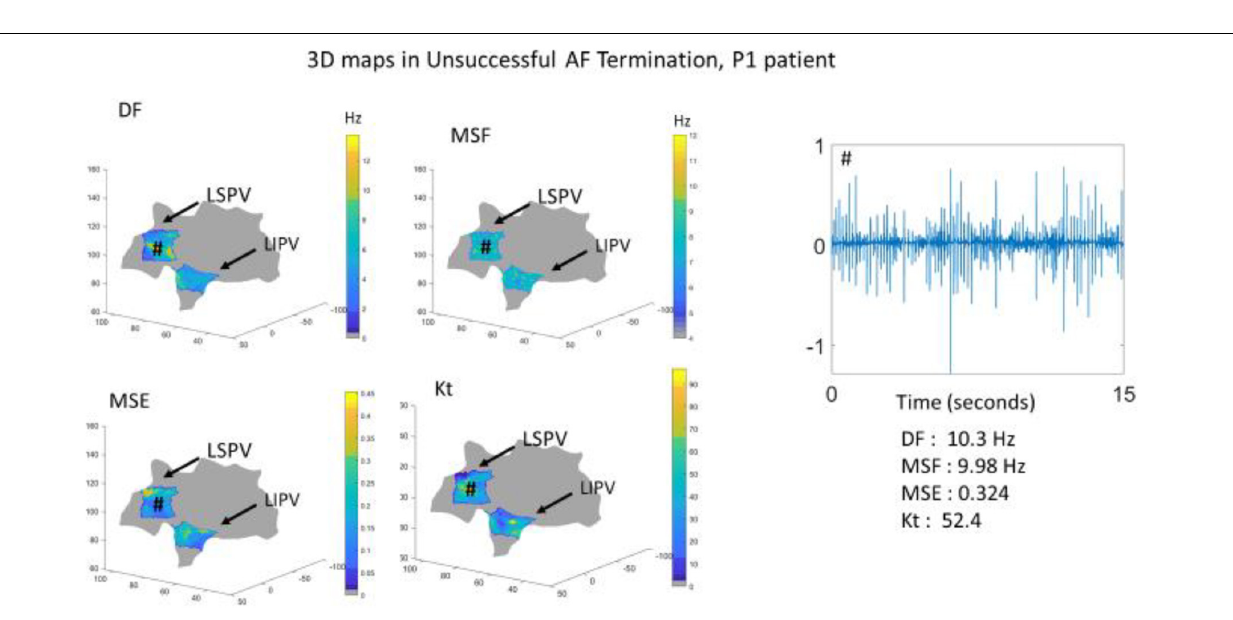
FIGURE 2 | The three-dimensional (3D) visualization of the individual approaches (DF, MSF, MSE, and Kt) generated using VIEgram software for a specific unsuccessful AF termination patient P1. Sample of BiEGM recorded from the left superior pulmonary vein (LSPV) (#) is shown along with individual DF, MSF, MSE, and Kt